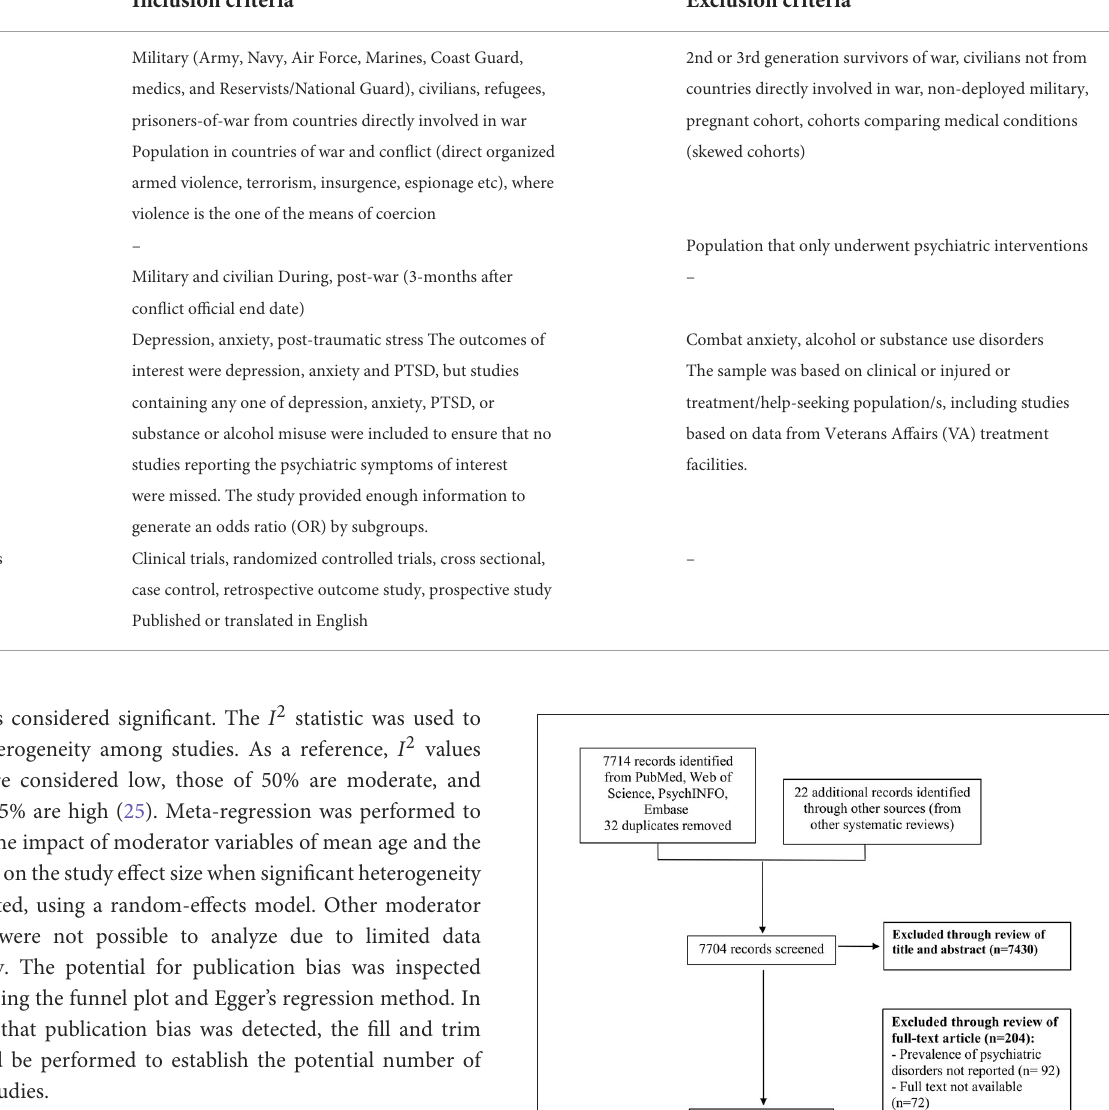
TABLE 1 PICOS, inclusion criteria and exclusion criteria applied to database search. PICOS